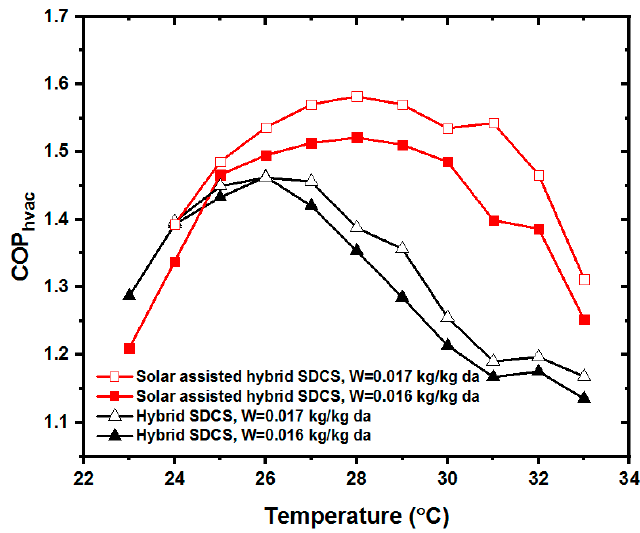
Figure 11. Comparison of the coefficient of performance ( COP hvac ) at different outdoor temperatures.